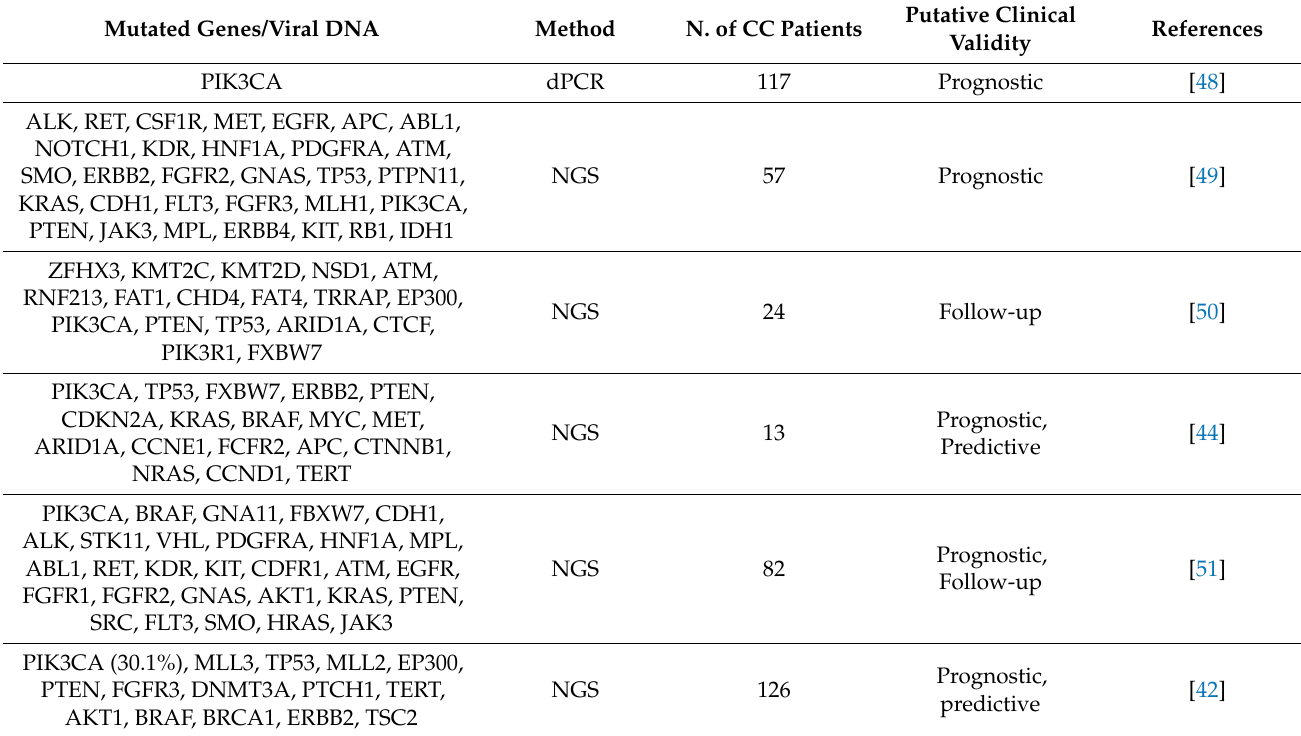
Table 2. Pre-clinical and clinical studies investigating the role of circulating ctDNA in